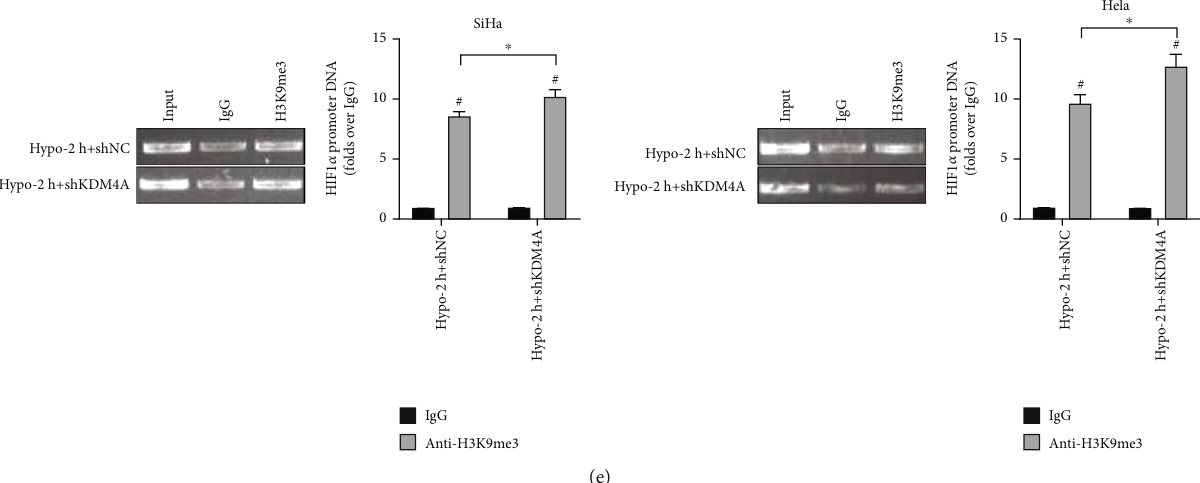
Figure 4: KDM4A mediated H3K9me3 to enhance the transcriptional activity of HIF1 α in hypoxia. SiHa and Hela cell lines were interfered with using shKDM4A and treated with hypoxia for 2 h. (A) The analysis map of HIF1 α expression pro fi le in TCGA CC database was obtained from the UALCAN website; (B) ENCORI pan cancer coexpression analysis showed a positive correlation between KDM4A mRNA level and HIF1 α mRNA level in CC cells; (C) The mRNA levels of KDM4A and HIF1 α in CC cells were detected by RT-qPCR; (D) The protein levels of KDM4A, HIF1 α and H3K9me3 in CC cells were detected by Western blot; (E) The level of H3K9me3 in HIF1A promoter was detected by ChIP assay. The experiments were conducted in 3 replicates independently. The data were expressed as mean ± standard deviation. The independent t test was used for comparison among groups. ∗ p < 0 : 05 , #compared with the IgG group, P < 0.05. CESC: Cervical squamous cell